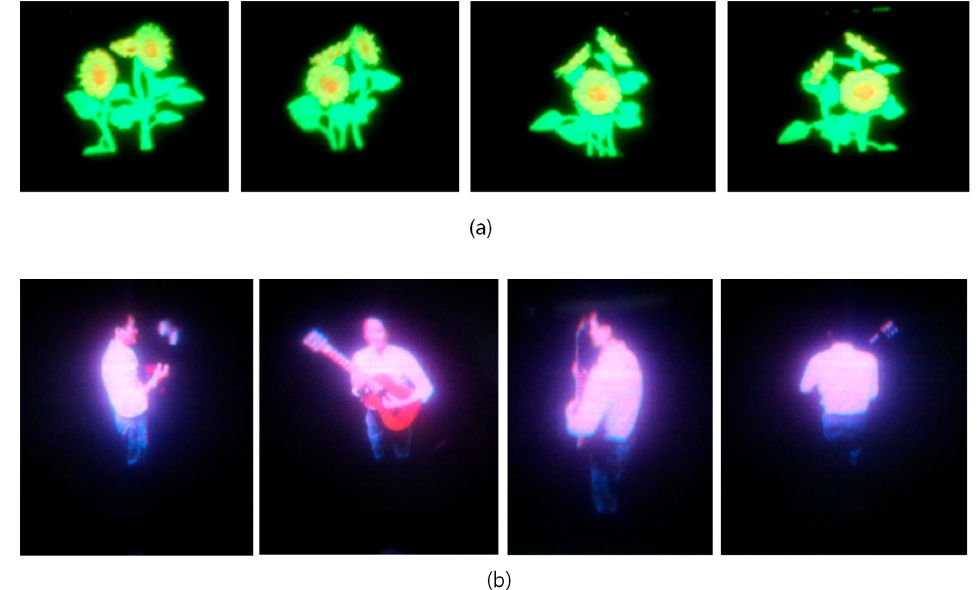
Figure 9. Optically-reconstructed hologram image captured from different horizontal viewpoints: ( a ) CG model and ( b ) real human object.